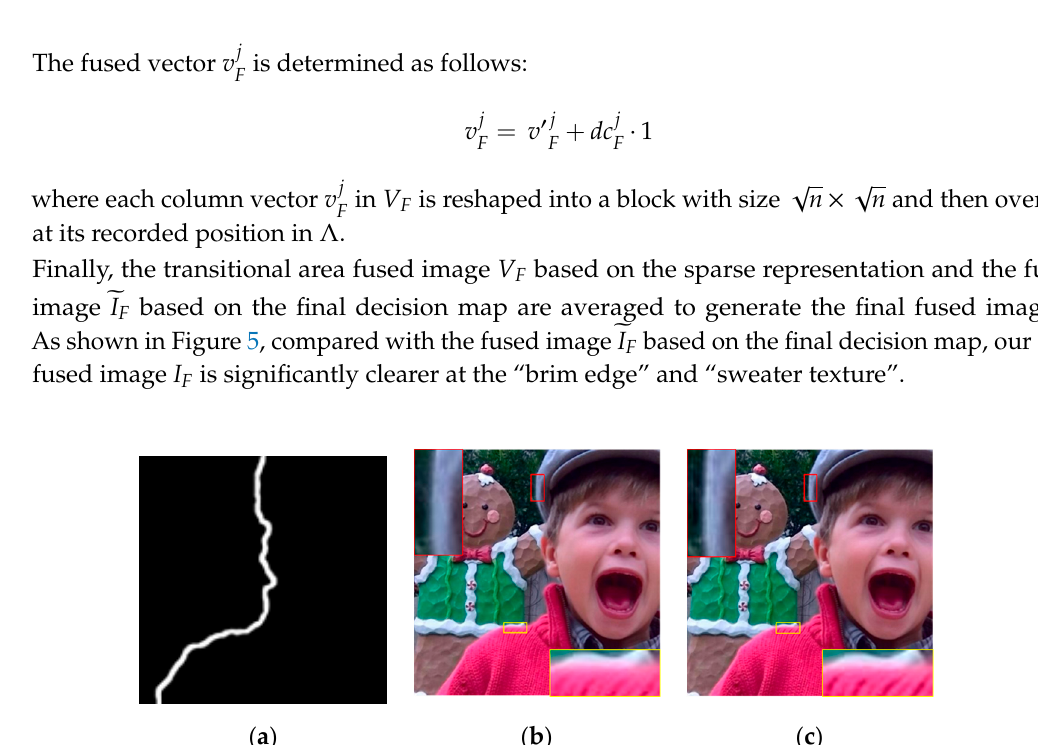
I  based on the final decision map; ( c ) the F